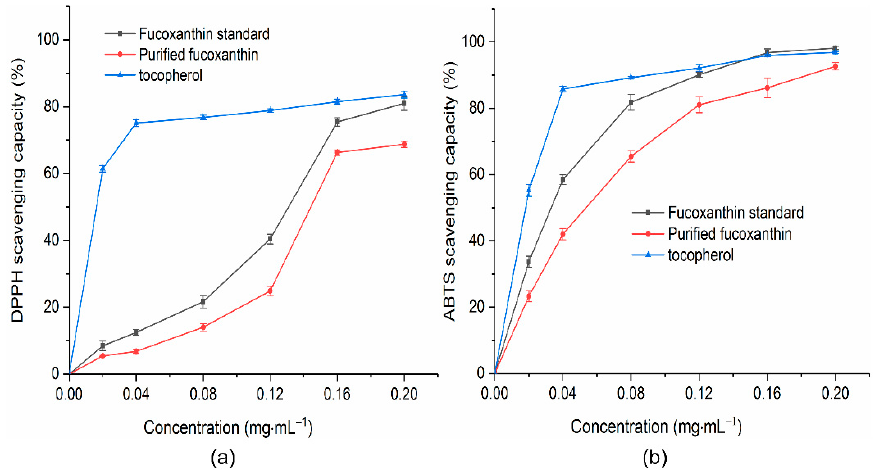
Figure 7. Antioxidant assays for the purified fucoxanthin from Phaeodactylum tricornutum : ( a ) scav- enging capacity of DPPH free radicals; ( b ) scavenging capacity of ABTS free radicals. EC 50 values were calculated by nonlinear regression